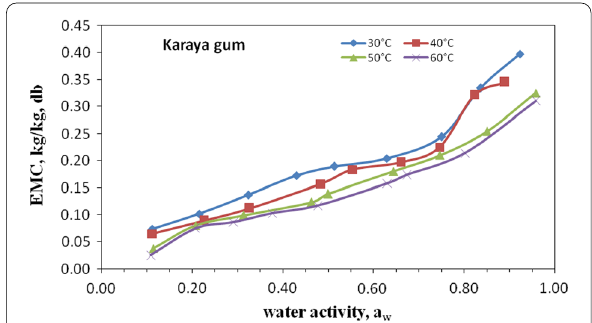
Fig. 3 Sorption isotherms of karaya gum at different